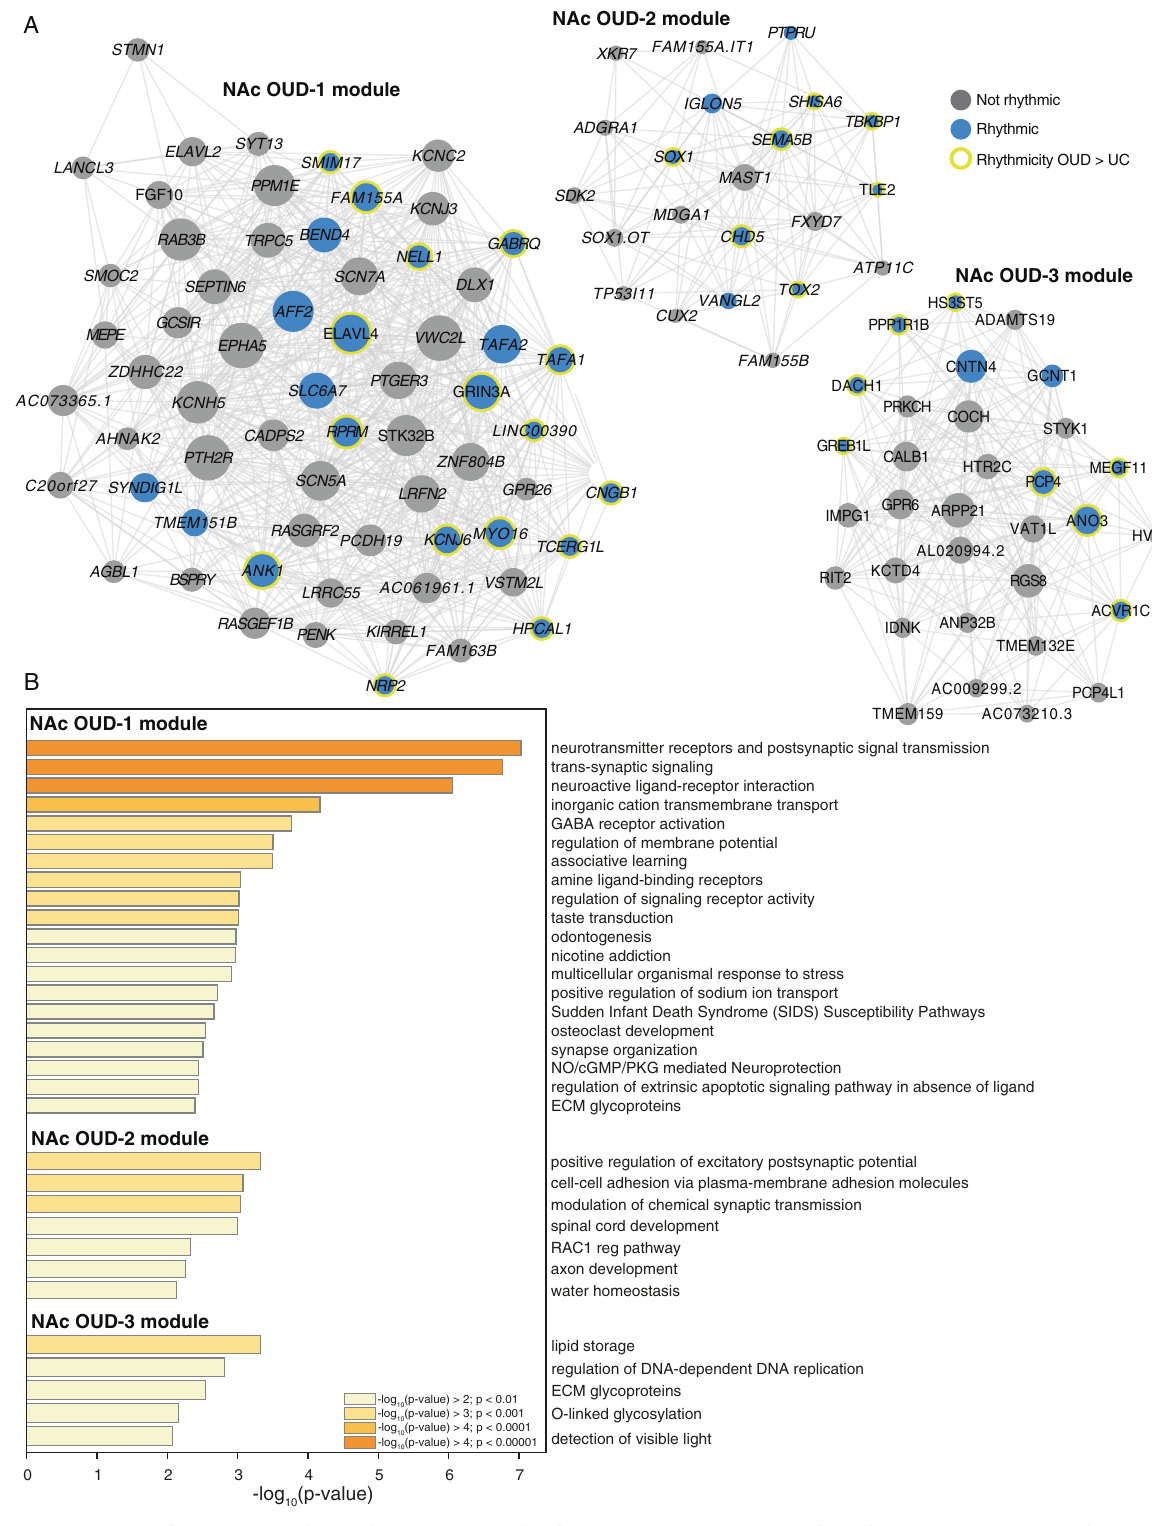
Fig. 4 OUD associated gene networks in the NAc. A Weighted gene co-expression network analysis (WGCNA) was used to generate co- expression modules, with the network structure generated on each brain region separately. The identi fi ed modules that survived module preservation analysis were arbitrarily assigned names and module differential connectivity (MDC) analysis compared the identi fi ed modules in OUD and unaffected comparison subjects. A MDC analysis indicated a gain of connectivity in the NAc for the OUD-1, OUD-2, and OUD-3 modules. Node size indicates the degree of connectivity for that transcript. Blue nodes indicate rhythmic transcripts and yellow halos indicate transcripts that were signi fi cantly more rhythmic in OUD. Edges indicate signi fi cant co-expression between two particular transcripts. B Pathway enrichment analysis within the NAc OUD-1 module, the NAc OUD-2 module, and the NAc OUD-3 module. Warmer colors indicate increasing − log 10 p